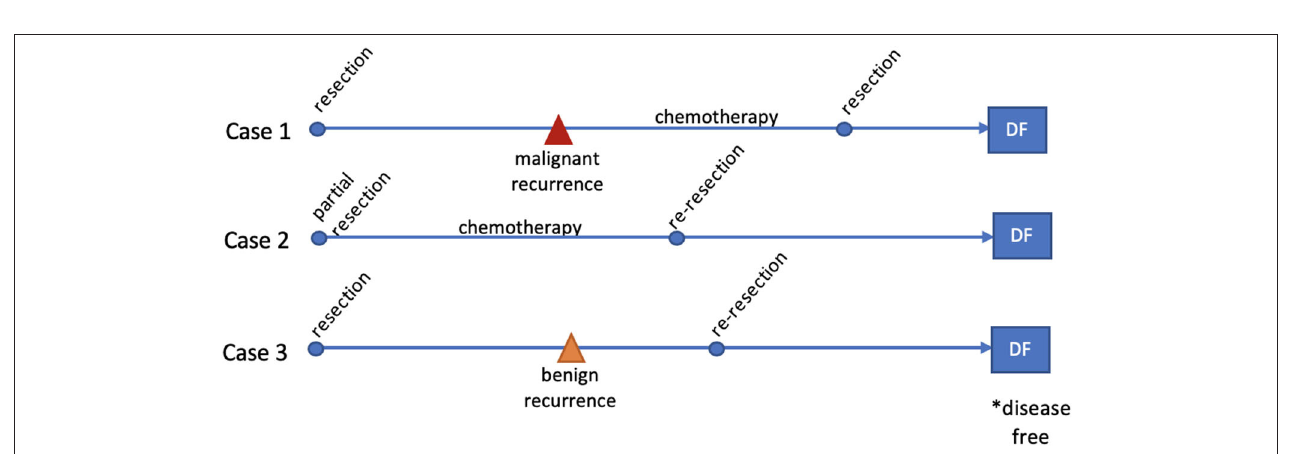
FIGURE 4 | Timelines for cases 1–3 summarizing treatment, recurrences and final